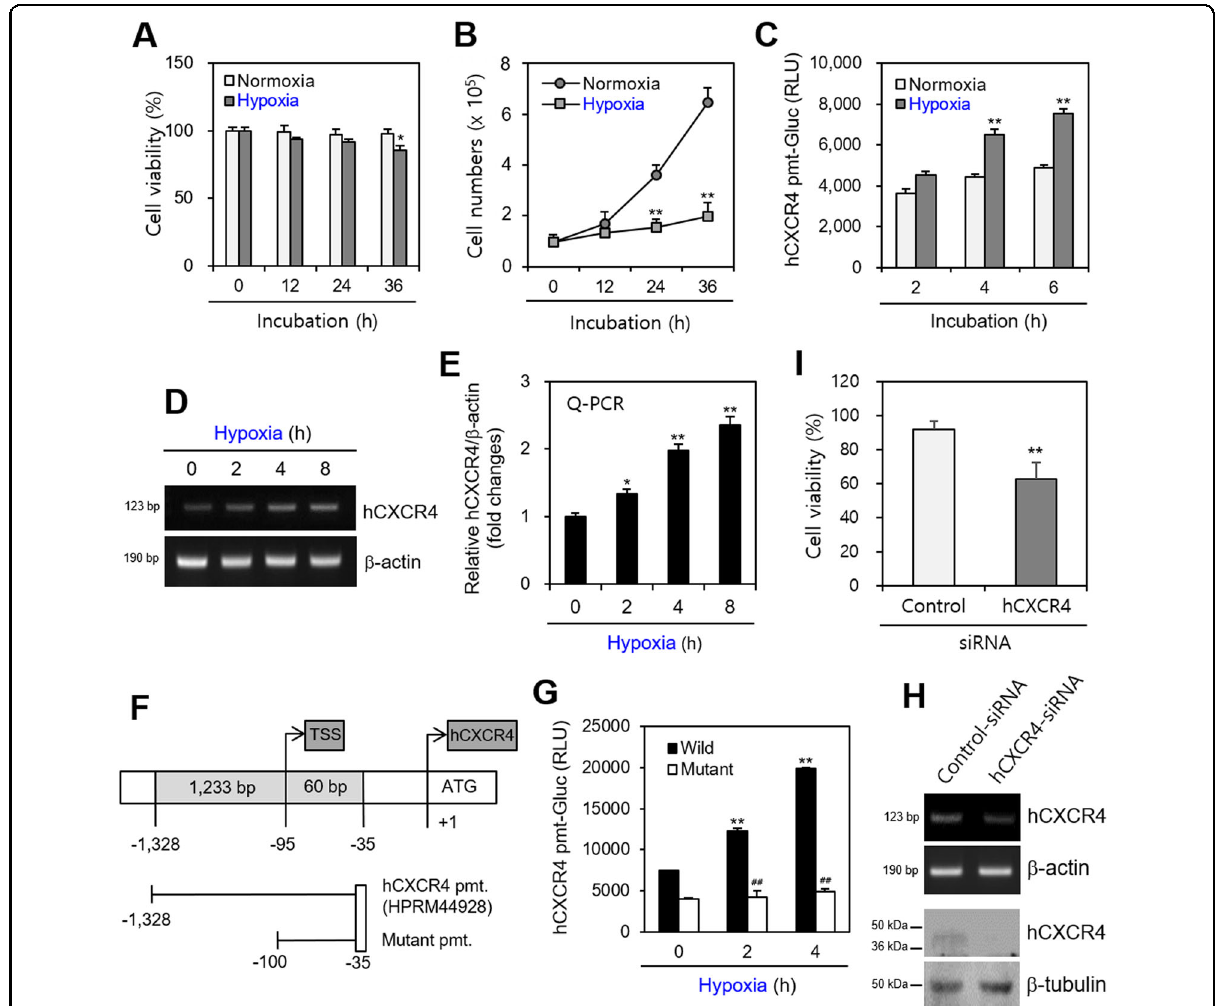
Fig. 1 B cell viability is regulated by hCXCR4 expression under hypoxic condition. A , B WiL2-NS cells were incubated for 12, 24, 36 h under normoxic or hypoxic conditions. Cell viability was assessed by using trypan blue exclusion assay ( A ) and cell number was calculated ( B ). C – E WiL2-NS cells were transfected with pEZX-PG02-hCXCR4-gaussia luciferase (Gluc) plasmid DNA using Viafect ™ . After 30 h transfection, WiL2-NS cells were incubated with hypoxia and Gluc activity of hCXCR4 promoter (pmt) was measured by using luminometer ( C ). RNA was extracted by using Nucleozol. mRNA of hCXCR4 was measured by RT-PCR ( D ) or real-time qPCR ( E ). F , G Mutant promoter to hCXCR4 was prepared from wild type promoter ( F ). WiL2-NS cells were transfected with wild-type or mutant-type pEZx-PG02-hCXCR4-Gluc promoter plasmid DNA. 30 h after transfection, WiL2-NS cells were incubated under hypoxic condition and Gluc activity was measured by using luminometer ( G ). H , I Cells were transfected with CXCR4-siRNA under normoxic condition. RNA was extracted by using Nucleozol. mRNA of hCXCR4 was measured by RT-PCR ( H , top). Cell lysates were prepared and the level of each protein was measured by western blot analysis ( H , bottom). Cell viability under hypoxic conditions was assessed by trypan blue exclusion assay ( I ). Each experiment was performed at least fi ve times. Data in bar or line graphs stands for the means ± SD. ** p < 0.01; signi fi cantly different from control group under normoxic condition ( A – C , E , G ) or negative control siRNA-treated group ( H ). ## p < 0.01; signi fi cantly different from control transfected with wildtype hCXCR4-pmt at each time point ( G